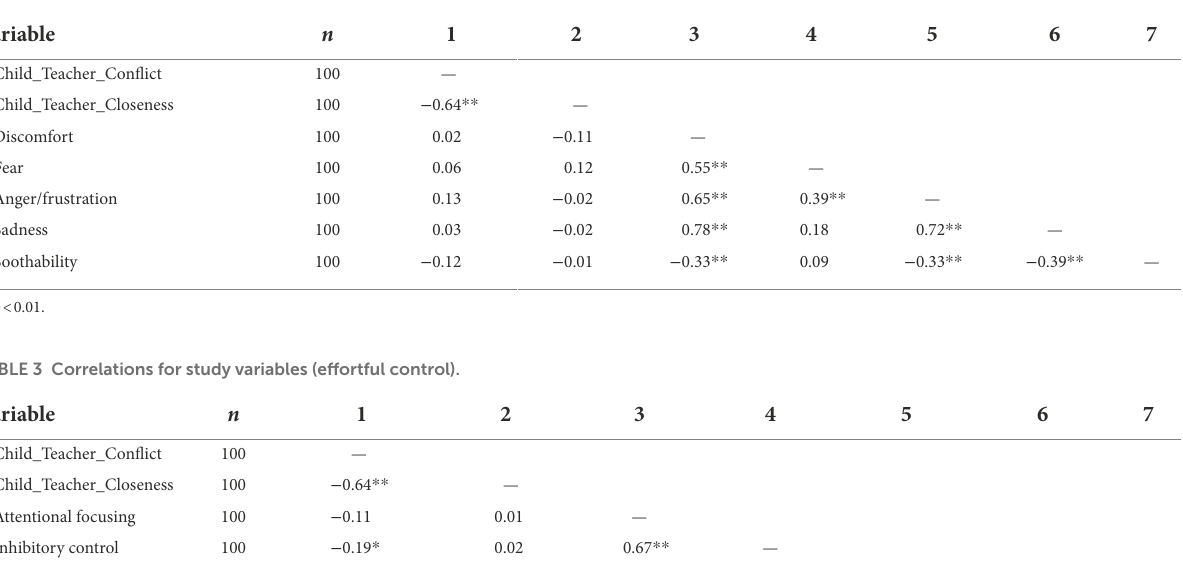
TABLE 2 Correlations for study variables (negative affectivity).